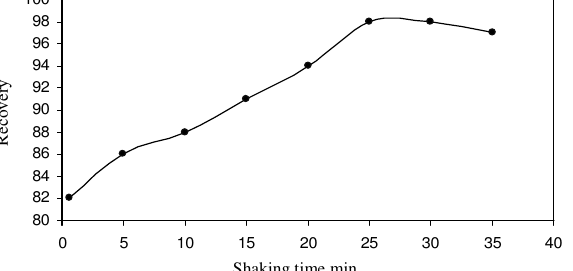
Figure 1 . Effect of shaking time (min) on the percentage extraction of Cr(III) by the modified nano polyacrylonitrile fiber